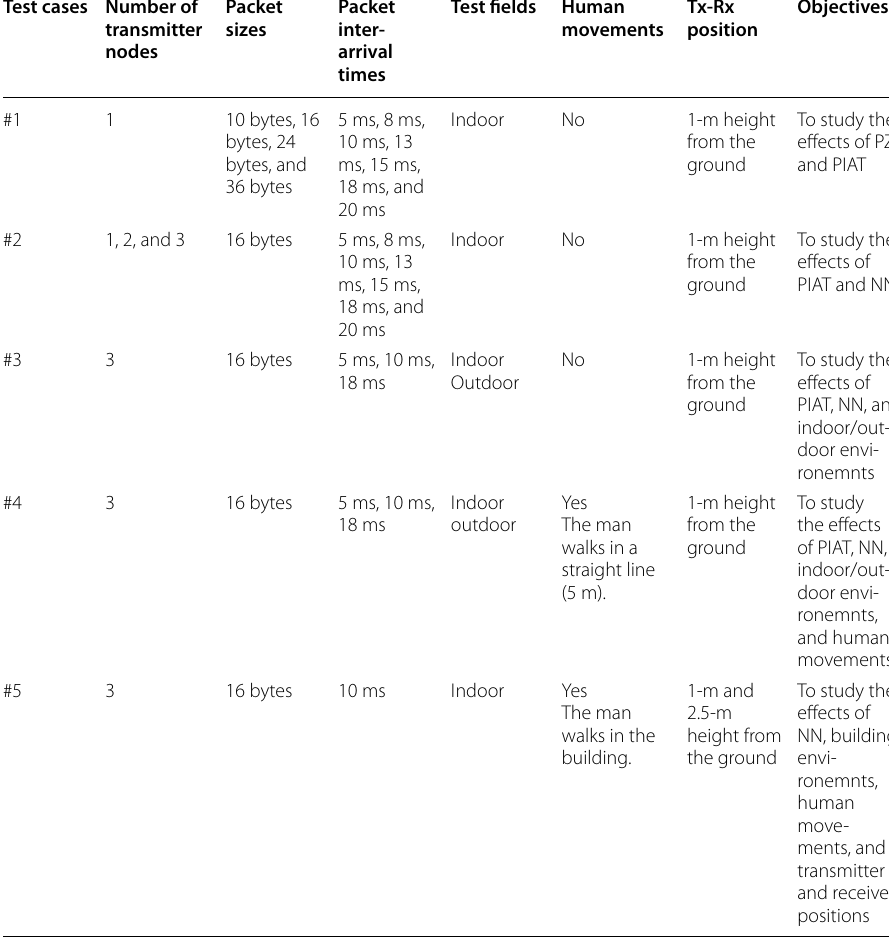
Table 1 Parameters set for each test case Test cases Number of